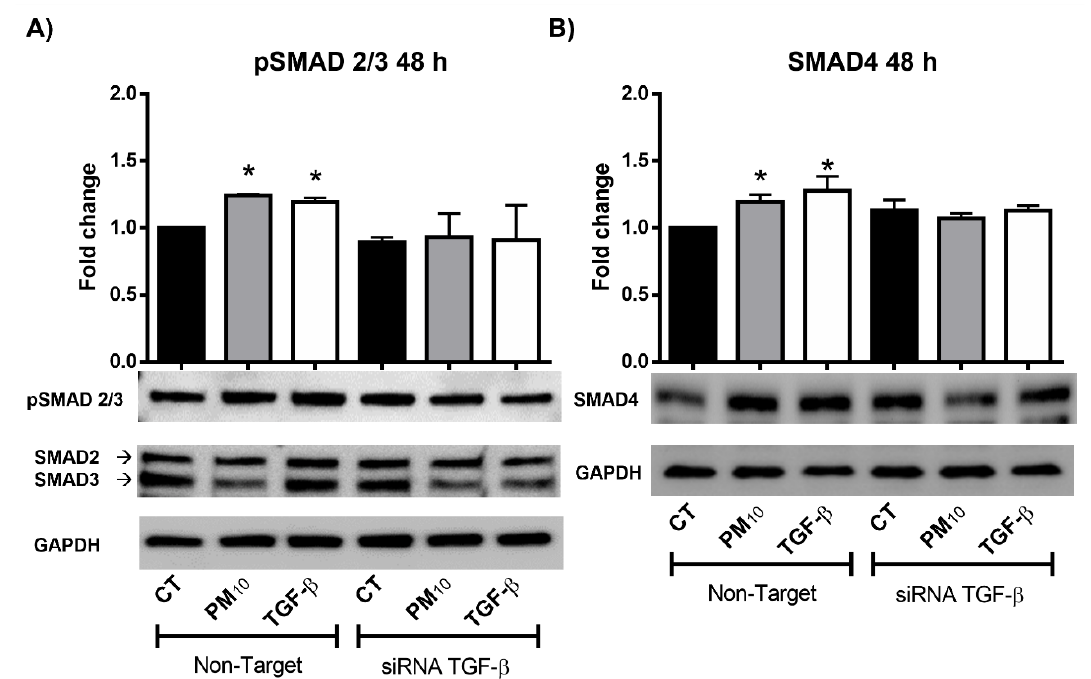
Figure 1. Particulate matter PM 10 increases the phosphorylation of SMAD2/3 and the levels of SMAD4 in A549 cells after 48 h of treatment: ( A ) Particulate matter exposure increases the phosphorylation levels of SMAD2/3 in A549 cells transfected with non-targeting siRNA, with a similar effect in cells treated with TGF- β for 48 h. ( B ) PM 10 exposure increases the protein levels of SMAD4 in A549 cells transfected with non-targeting siRNA, with a similar effect in cells treated with TGF- β for 48 h. These effects are not prevented in A549 cells transfected with TGFB1 siRNAs. Cells were exposed to PM 10 (10 µ g/cm 2 ) and TGF- β (5 ng/mL) for 48 h. The quantitative results were expressed after normalization using GAPDH as a loading control. Data are reported as the means ± SD of three independent experiments. The images are representative of the data obtained. (*) indicates statistically differences between treatments. Densitometry was performed using arbitrary units p < 0.05.